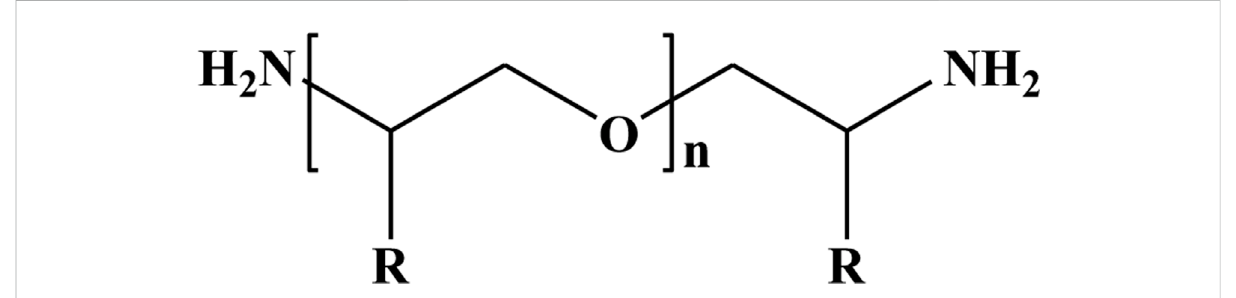
FIGURE 6 Molecular structure of amino-terminated polyoxypropylene (R represents H or CH 3 ; n & 10).